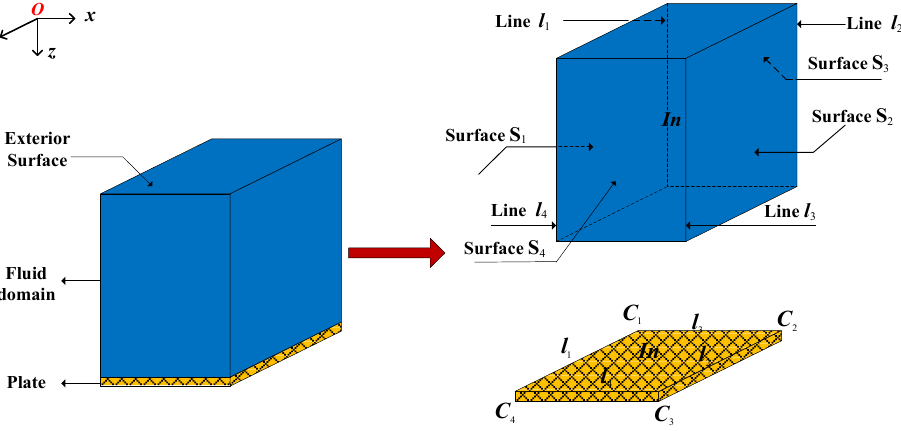
Figure 1. Schematic diagram of a two-dimensional periodic unit cell model of the fluid-loaded plate.